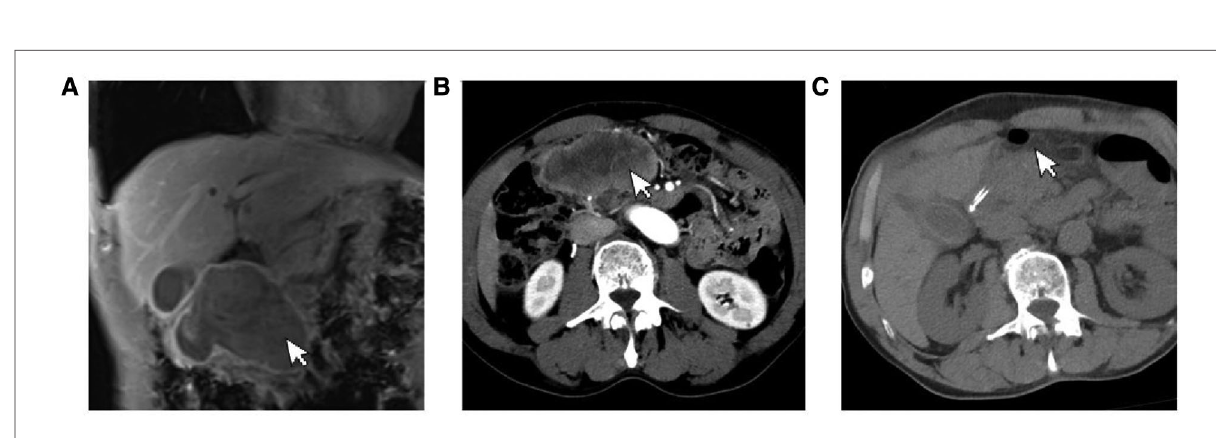
FIGURE 3 ( A ) The gastric antrum occupies space, the main lesion is located outside the gastric wall. ( B ) Patient ’ s preoperative CT showed obvious lesions. ( C ) Postoperative CT of the patient showed signi fi cant resection of the